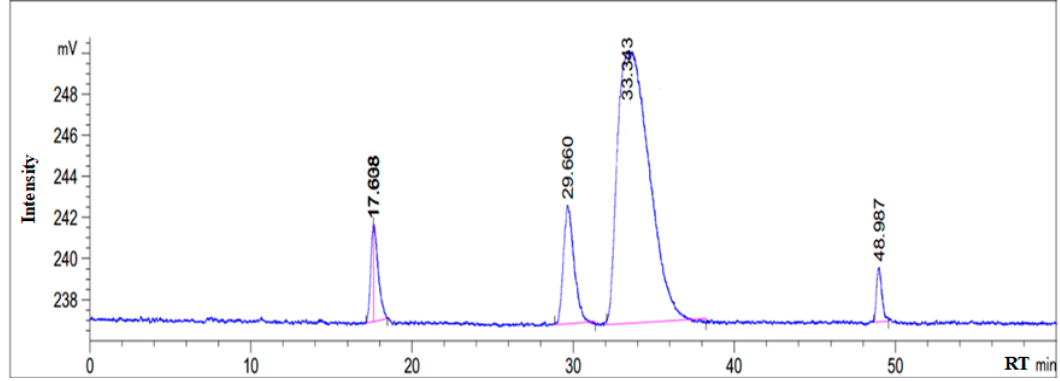
Figure A1. HPLC chromatogram for 0.5 wt.% Oleic acid.